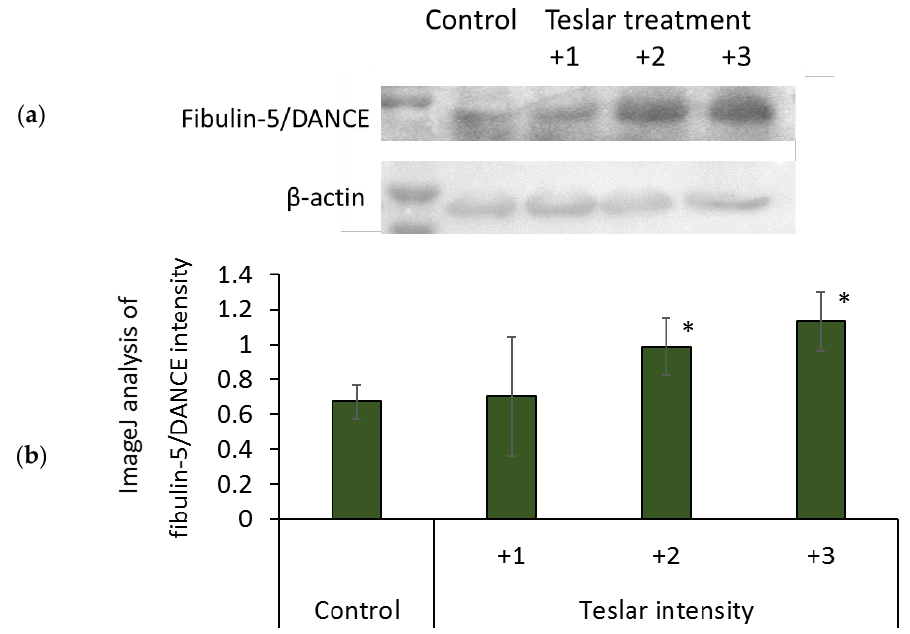
Figure 7. Effect of Teslar treatment on fibulin-5/DANCE in collagen gel-cultured human fibroblasts. ( a ) Western blotting of fibulin-5/DANCE in cultured human fibroblasts and ( b ) image analysis of fibulin-5/DANCE intensity. The results are expressed as the mean ± standard deviation of three experiments. * p < 0.05 vs. Control.